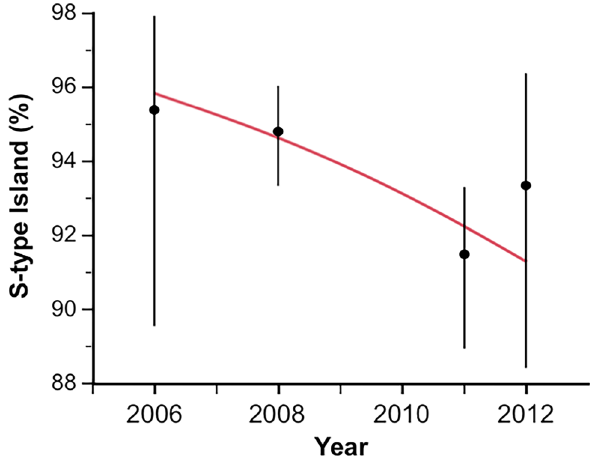
Figure 5. Kdr introgression and species-specific 2L island recovery in An. coluzzii —Following the initial selective introgression of the 2L An. gambiae island into An. coluzzii new recombinant 2L-islands haplotypes featuring an An. coluzzii -like pericentromeric region and the introgressed kdr allele appeared. A new selective sweep associated with these haplotypes quickly led to a decrease in the frequency of An. gambiae pericentromeric 2L-island loci in An.